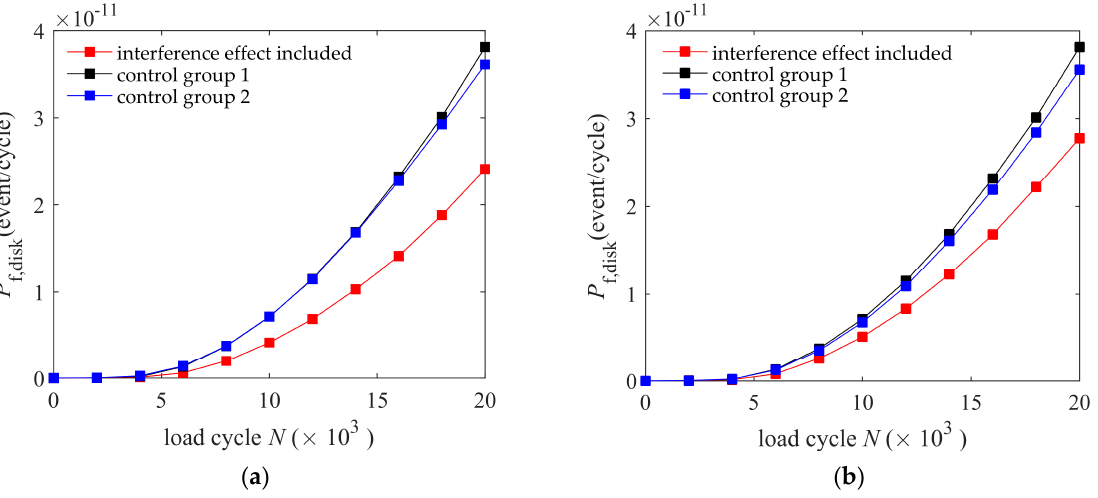
Figure 9. Failure risk results under different stress scatter coefficient distributions: ( a ) failure risk when X ~U(1,0.050 2 ); ( b ) failure risk when X~ U(1,0.033 2 ).